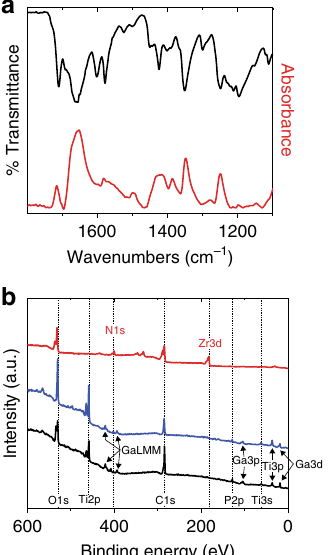
Fig. 2 Surface characterization of Zr(NDI) ∣ TiO 2 @GaP. a ATR-FTIR transmittance spectrum of bulk Zr(NDI) powder (black) and absorbance spectrum of Zr(NDI) ∣ TiO 2 @GaP (red). b Survey XPS spectra of TiO 2 @GaP (black), NDI ∣ TiO 2 @GaP (blue), and Zr(NDI) ∣ TiO 2 @GaP (red). Corresponding characterization for Si substrates can be found in the Supplementary